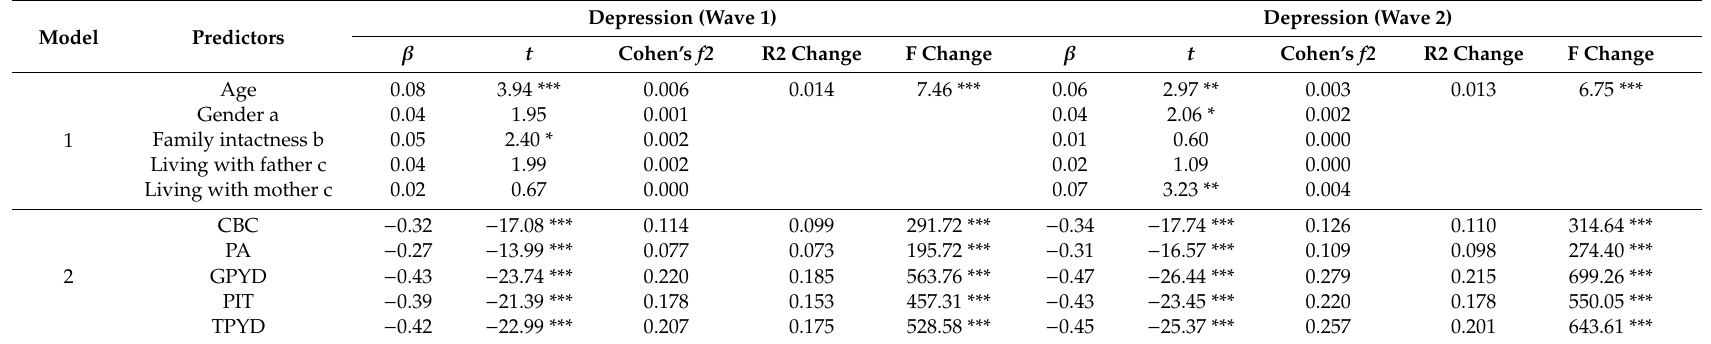
Table 3. Cross-sectional regression analyses for depression.